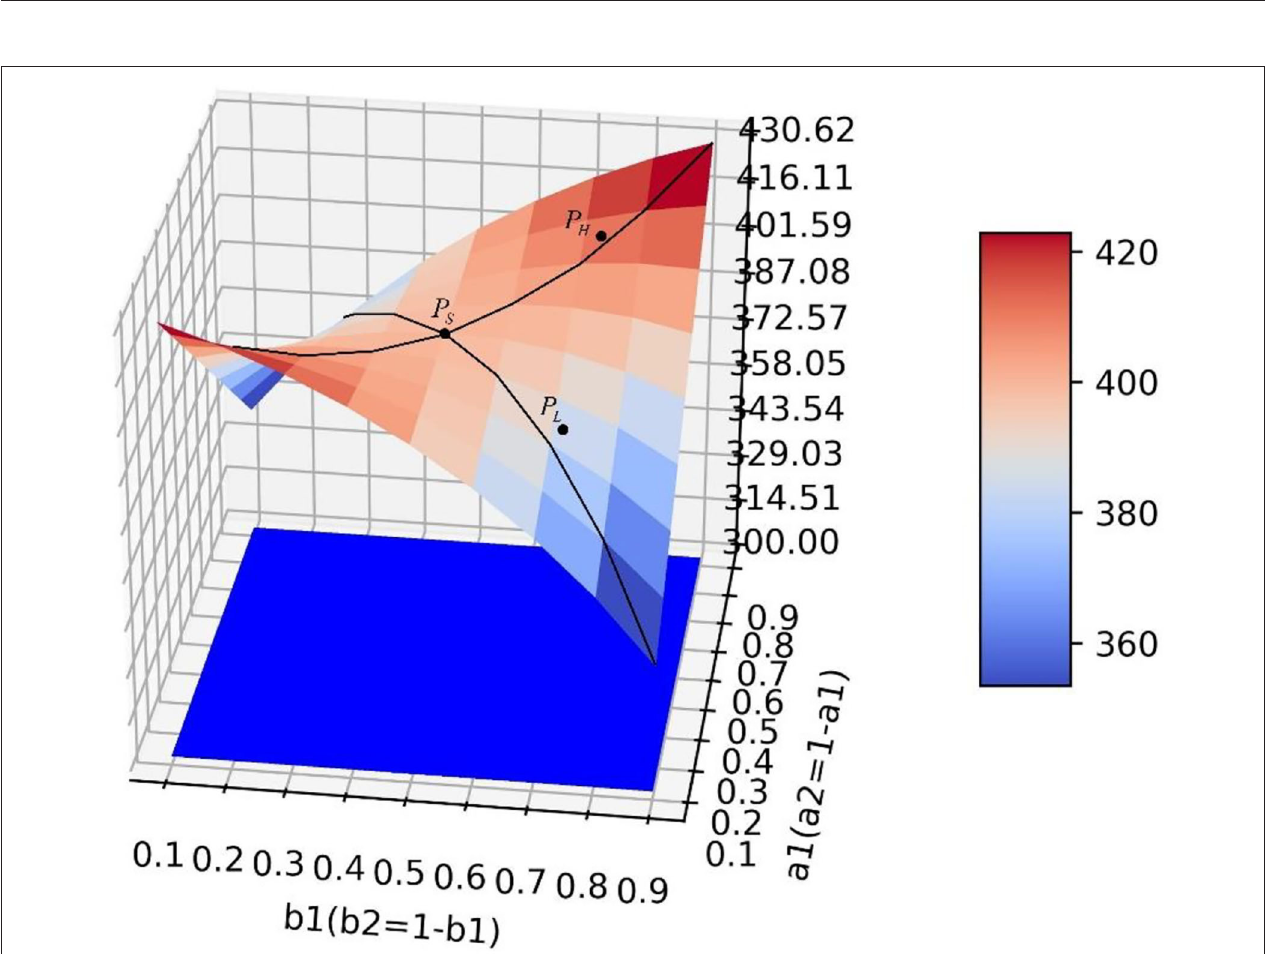
FIGURE 10 | In the scene of simulation 4, the value of positive emotion at the equilibrium point: surface graph and surface projection.